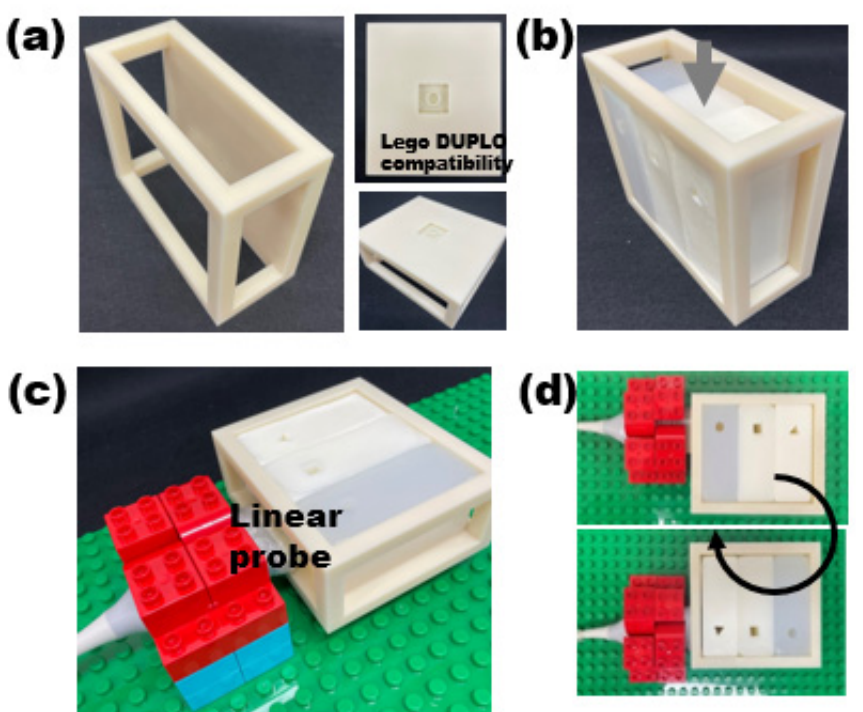
Figure 3. Experimental setup for the ultrasound imaging of the emulsion gel phantom using a modular frame. ( a ) LEGO-compatible modular frame. ( b ) It consists of an open frame so that it is easy to insert a phantom and scan images from multiple directions. ( c ) In order to increase reproducibility, an ultrasound image was obtained by fixing the transducer with a LEGO block. ( d ) The phantom was rotated clockwise and scanned.